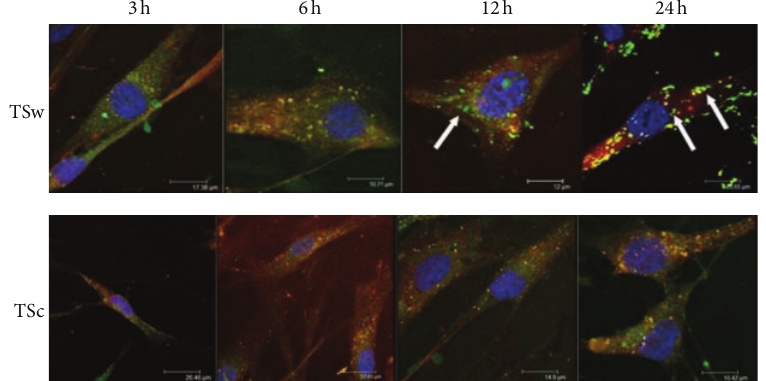
Figure 5: Internalization of green fluorescent FITC-TSw, respectively, FITC-TSc (50 𝜇 g/mL) by NHDF analyzed via laser-scanning confocal microscopy after incubation of 3 h, 6h, 12h, and 24h. Blue fluorescence: DAPI-stained nuclei; red fluorescence: endosomes labeled with Dextran-TexasRed; yellow fluorescence: colocalization of FITC-TSw, respectively, FITC-TSc and Dextran-TexasRed within the